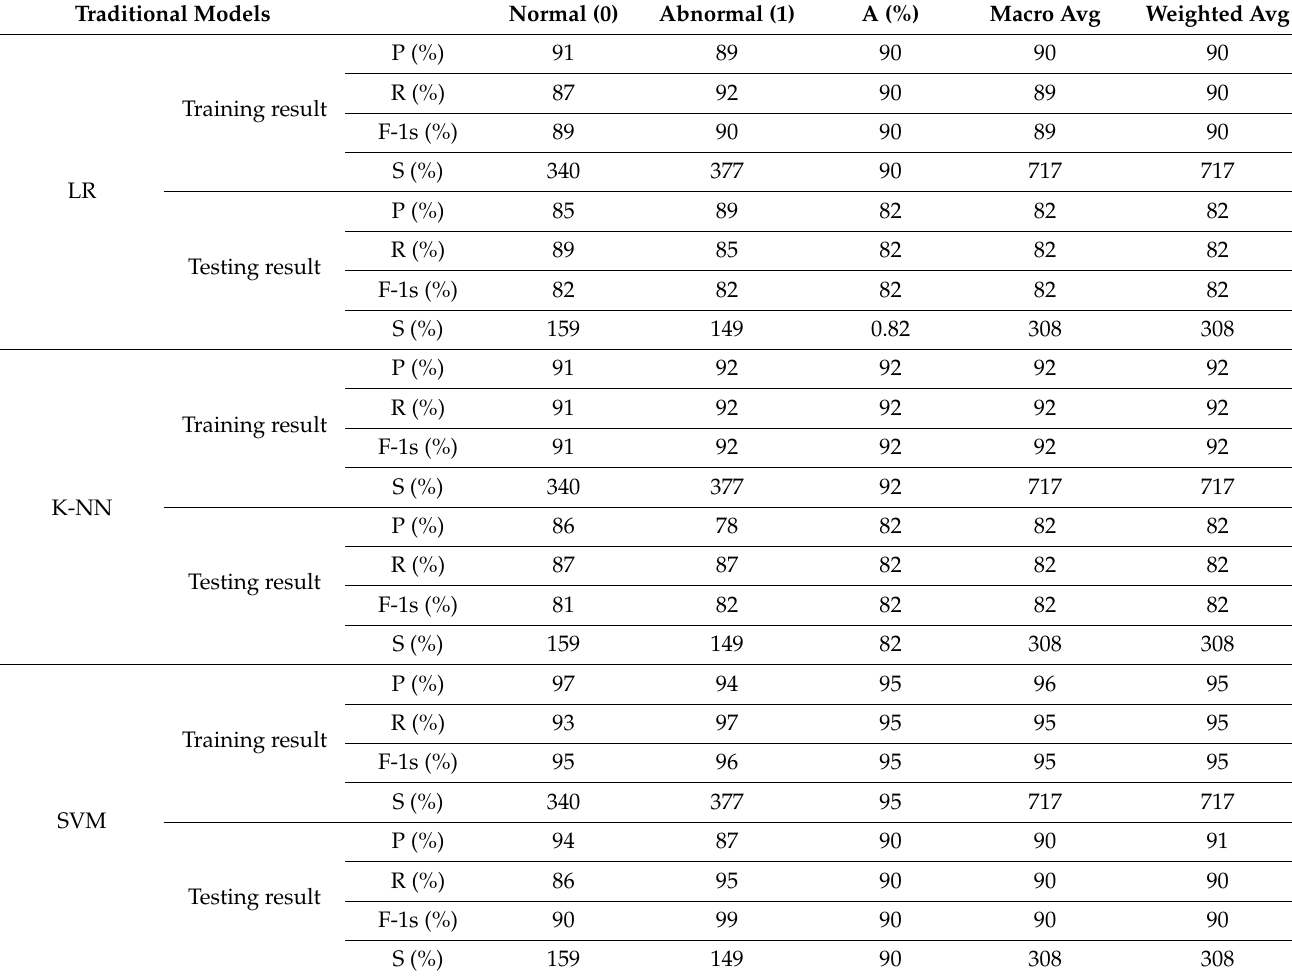
Table 9. Classification report of various types of training and testing of traditional